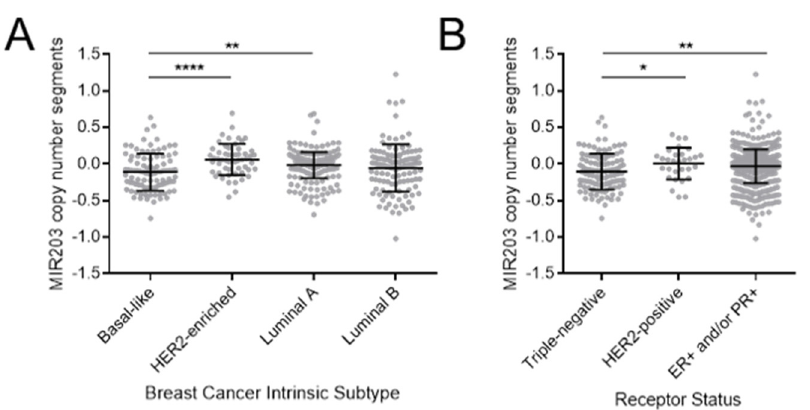
Figure 6. MIR203 copy number is reduced in basal-like and triple-negative breast cancers. Copy number data were obtained for patients with breast adenocarcinoma (BRCA) in the TCGA dataset using the UCSC Xena browser. Cases were stratified based on ( A ) intrinsic subtype according to the PAM50 method or ( B ) histological determination of estrogen receptor (ER), progesterone receptor (PR), or human epidermal growth factor receptor 2 (HER2) positivity. The mean and standard deviation are indicated by central bar and error bars. p -value calculated using Student’s two-tailed t -test. * p < 0.05, ** p < 0.01, **** p <0.0001 .